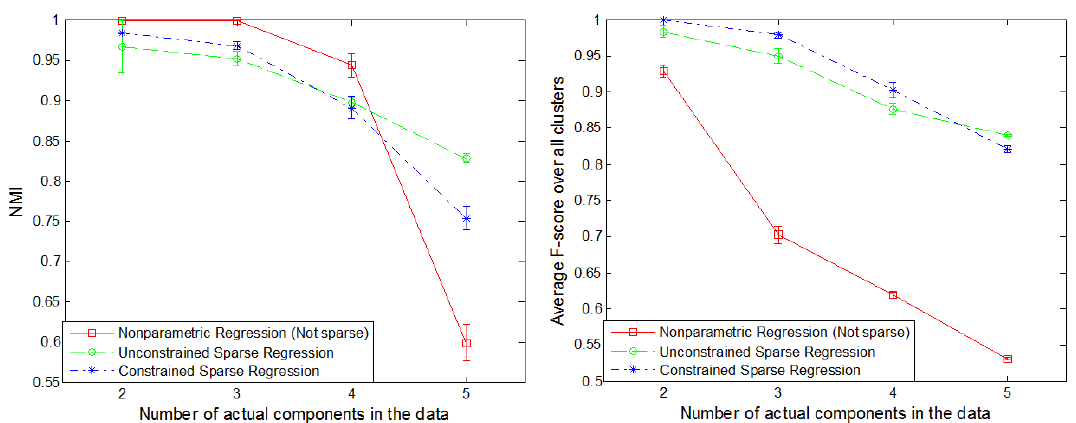
Figure 2. Left panel: ability of nonparametric unregularized and sparse regressions (unconstrained and constrained) to correctly identify clusters in presence of increased number of actual components in the data. Right panel: ability of nonparametric unregularized and sparse regressions (unconstrained and constrained) to correctly retrieve the sparse structure within each cluster.